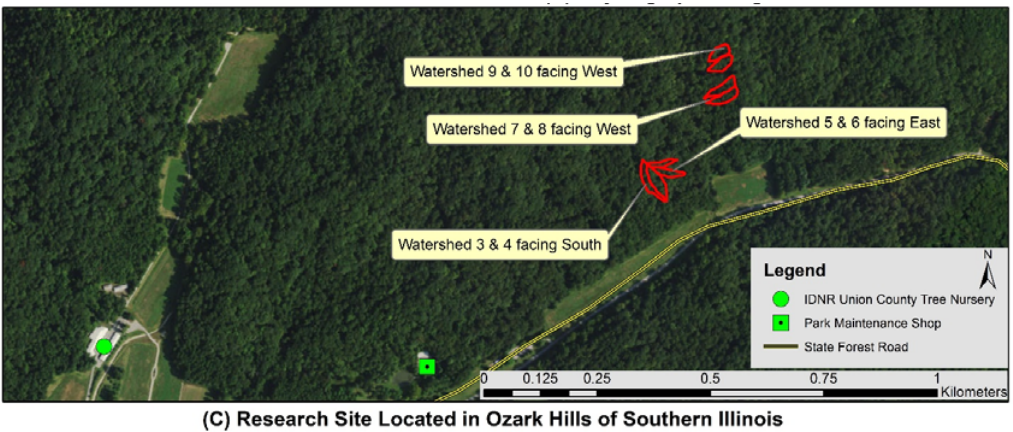
Figure 1. ( A ) Forest regions of the United States: (1) Northern Conifer ‐ Hardwood forest, Aspen Parkland; (2a) Northern Hardwood ‐ Conifer Forest (Sugar Maple ‐ Yellow Birch ‐ American Beech ‐ White Pine Forest), Great Lakes Section; (2b) Northern Hardwood ‐ Conifer Forest, New England Section; (3a) Central Hardwood Forest (Oak ‐ Hickory and mesophytic elements), Plateau section; (3b) Central Hardwood Forest, Appalachian Mountain section; (4a) Southeastern Pine ‐ Hardwood Forest, Upper Coastal Plain; (4b) Southeastern Pine ‐ Hardwood Forest, Lower Coastal Plain; (4c) Southeastern Pine ‐ Hardwood Forest, Piedmont Plateau; (5a) Southwestern Juniper ‐ Pinyon Savanna; (5b) Central and Southern Rocky Mountain Mixed Conifer Forest; (6) Northern Rocky Mountain Conifer Forest; (7a) Northern Coastal Conifer Forest; (7b) Sierra Nevada Mountain, Southern Coastal Conifer Forest. Other zones include grassland (G), desert (D), and the Mississippi River Valley (MRV). Adapted from Fralish and Franklin [35]. ( B ) Physiographic regions of southern Illinois: (1) Illinois Ozark Hills; (2) Greater Shawnee Hills; (3) Lesser Shawnee Hills; (4) Cretaceous Hills; (5) Mississippi River Alluvial Plain; (6) Lower Ohio ‐ Wabash Rivers Alluvial Plain; (7) Ohio ‐ Cache Rivers Alluvial Plain. ( C ) Research site location at Trail of Tears State Forest in the Ozark hills of southern Illinois.